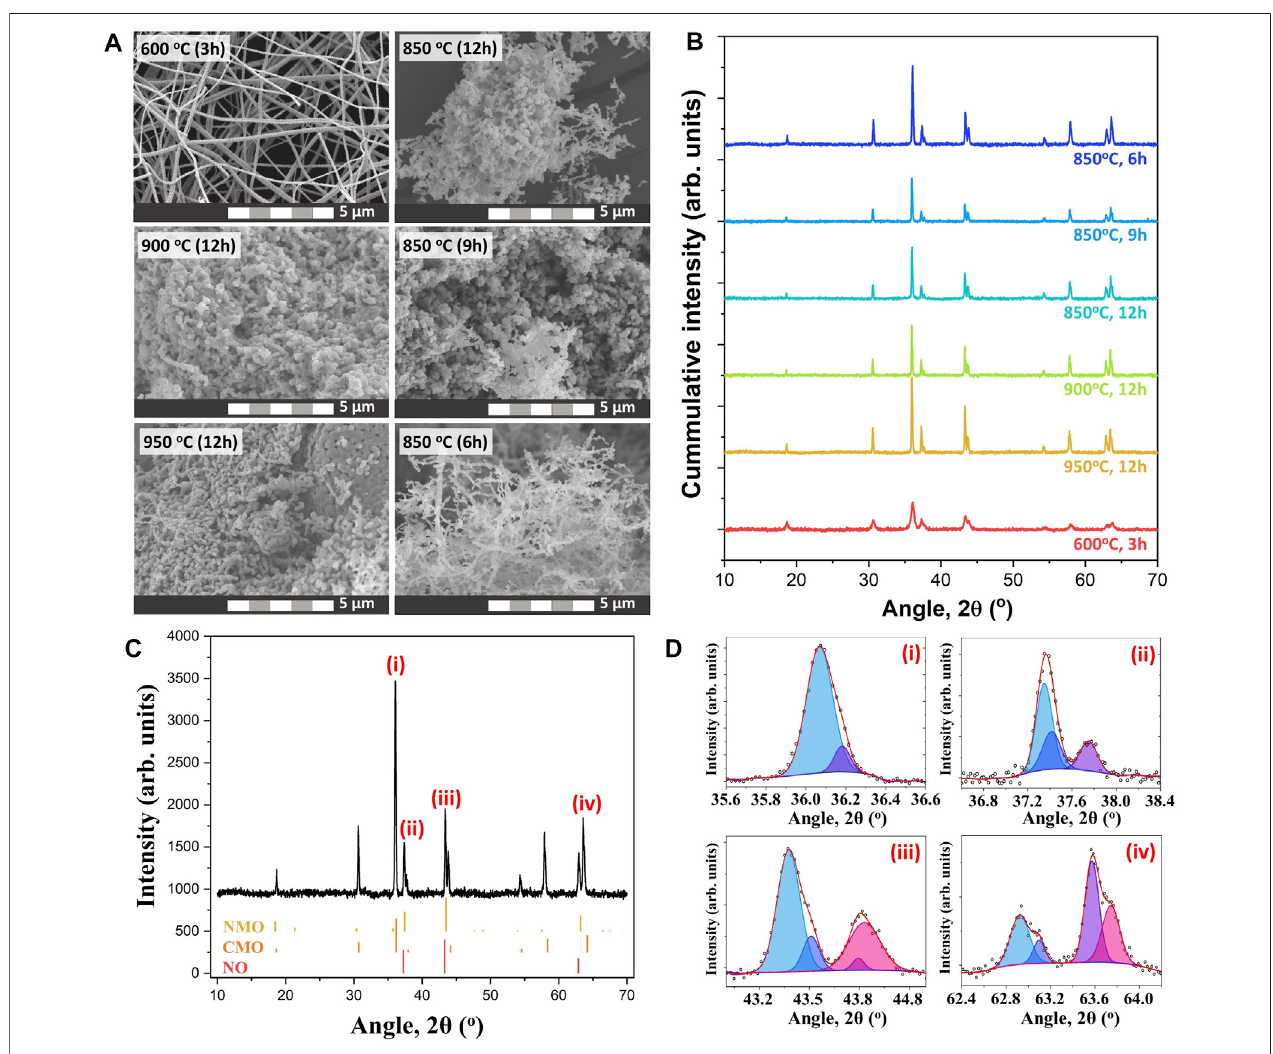
FIGURE 1 | (A) FESEM images of the sample calcined under different calcination parameters. (B) XRD spectra showing the crystal structure of the sample after calcination. (C) Coexistence ofmultiple crystal phases within the quaternary metal oxide. (D) Deconvolution of XRD peaks showing the present of the secondary phase.